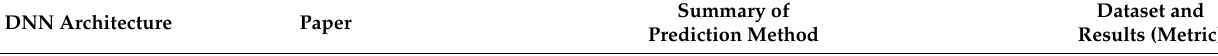
Summary of Prediction Method